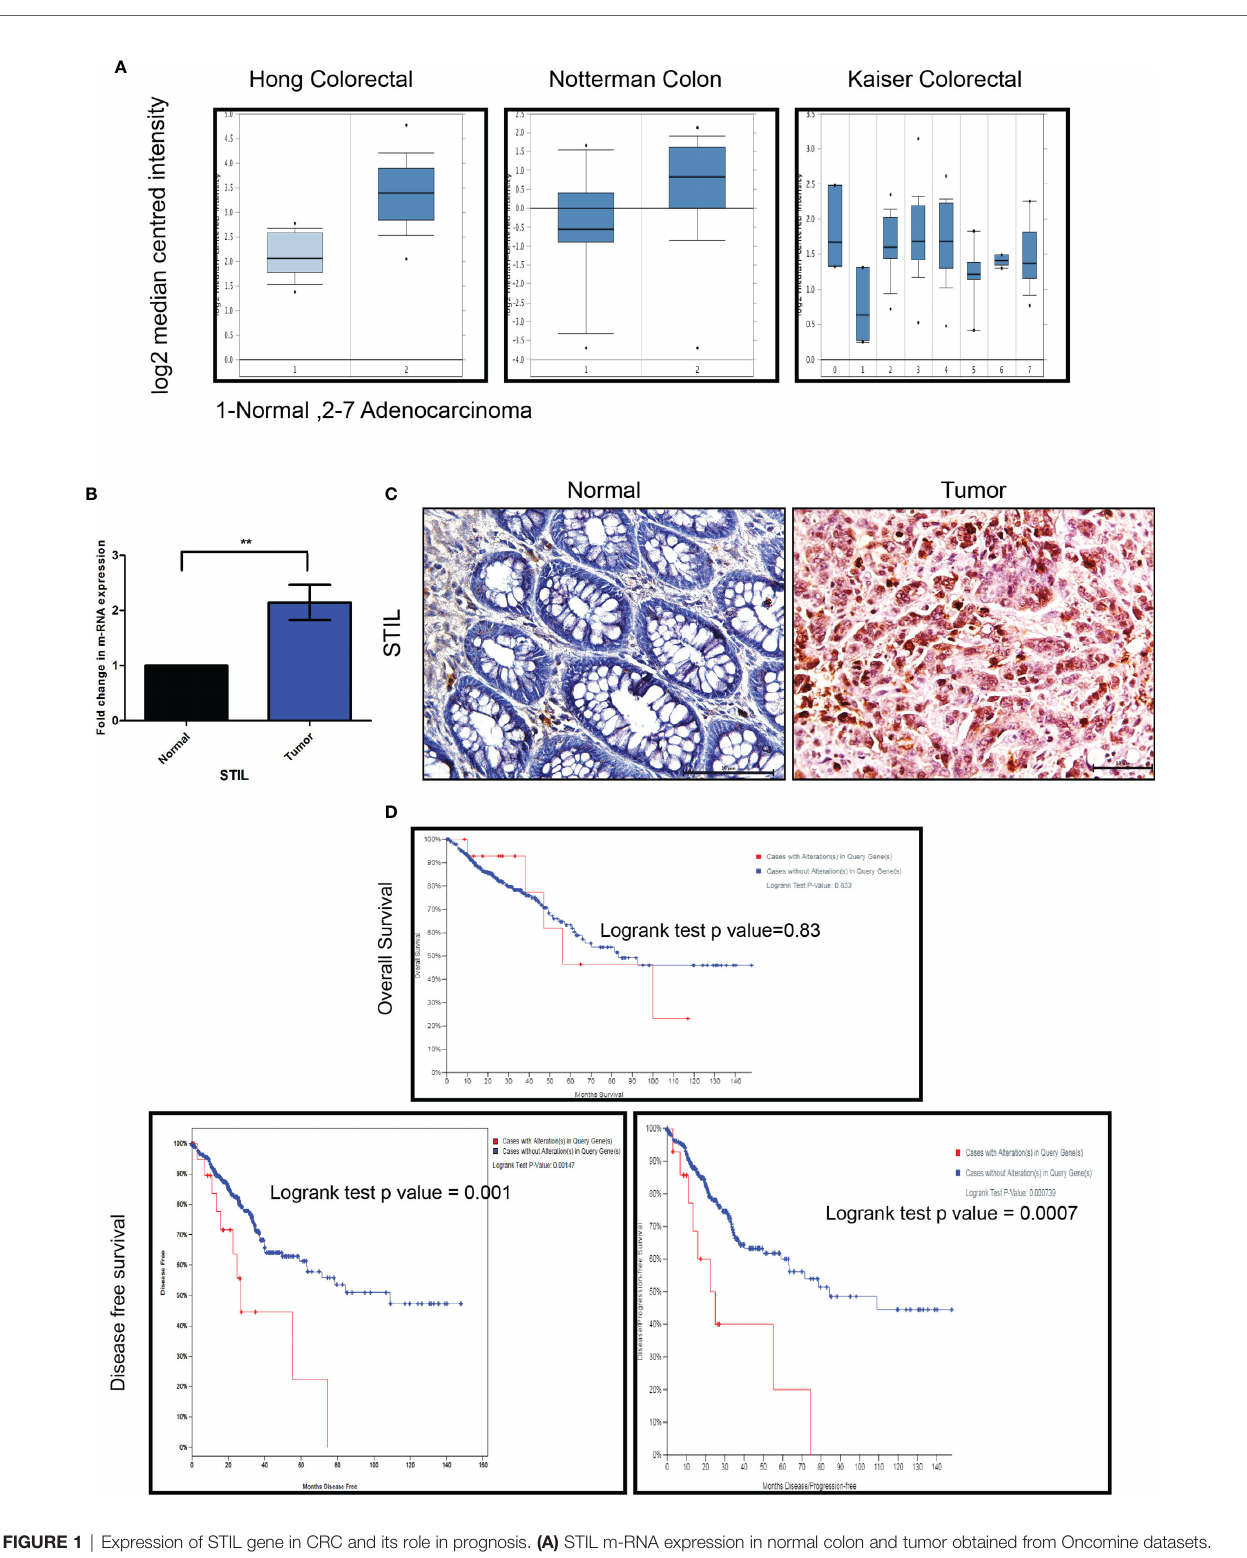
FIGURE 1 | Expression of STIL gene in CRC and its role in prognosis. (A) STIL m-RNA expression in normal colon and tumor obtained from Oncomine datasets. (B, C) Differential expression of STIL gene mRNA (N=22) and protein in CRC. (D) Kaplan-Meier plot showing association of high mRNA expression with patients ’ survival and disease free survival in CRC cases. One Sample t-test and log rank test results showing p value ≤ 0.01 is represented by **, Scale bar is 20µm. Note: In Kaplan-Meier plot, red and blue line in indicates high and low m-RNA expression